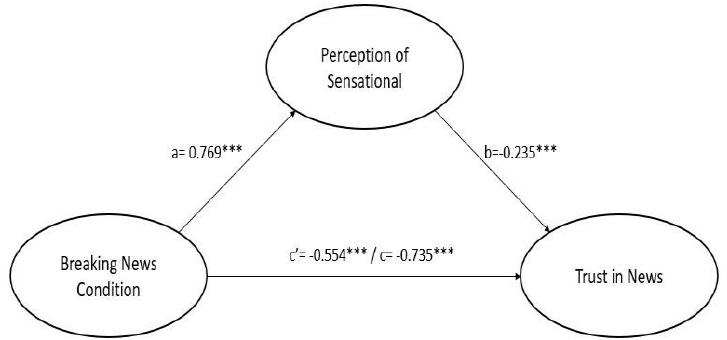
Figure 2. The mediation model (where *** represents p < 0.01)